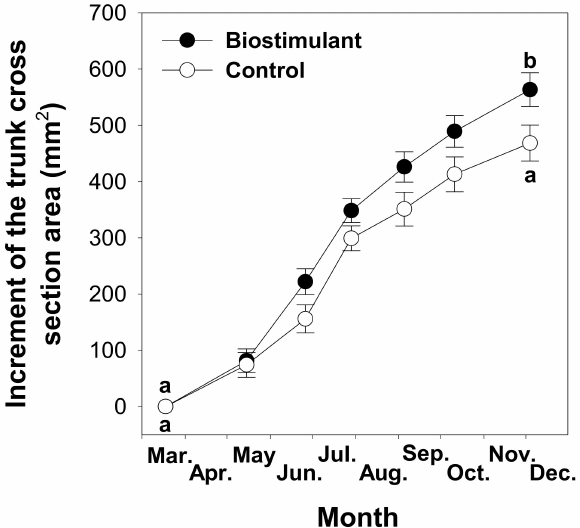
Figure 4. Increment of growth of the trunk cross section area of treated and control trees in the field during the vegetative season of 2019. Bars represent standard errors. At the beginning and at the end of the experiment, means accompanied by di ff erent letters are significantly di ff erent at p < 0.05.